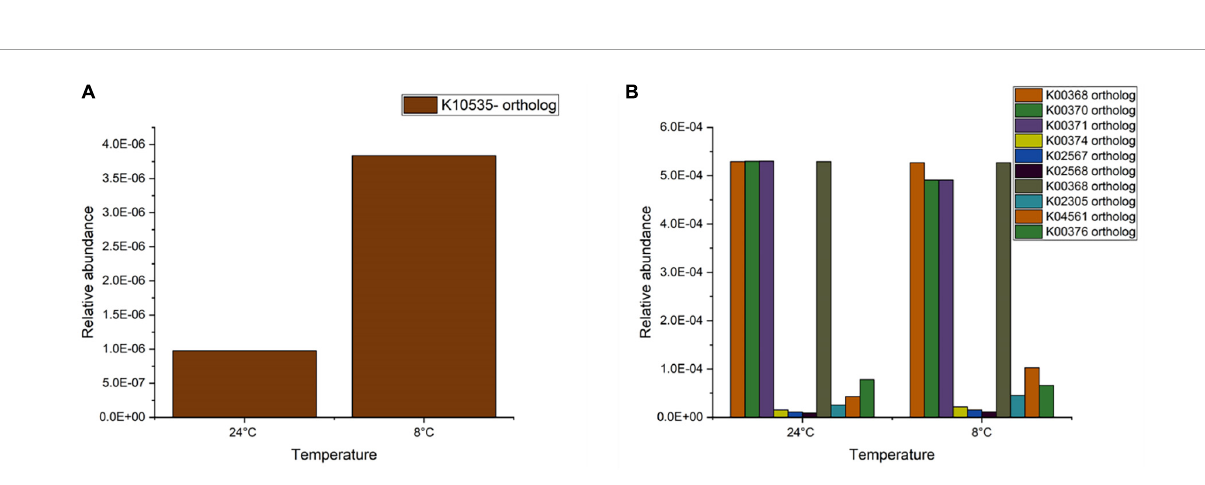
FIGURE5 Relative abundance of (A) nitrification and (B) denitrification orthologues present in biomass samples at 24 and 8 ◦